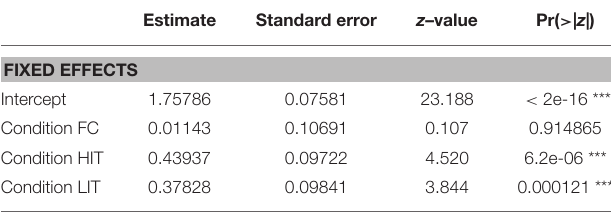
FIGURE 6 | Duration of gazing. Box and whiskers plot showing the duration of gazing at E1 in SCP and FPP of NC, FC, LIT, and HIT conditions. Boxes represent interquartile range, horizontal bars within boxes indicate median values, and whiskers represent the upper range of the data. TABLE 2 | GLM results showing the effect of experimental conditions on gazing behavior in the